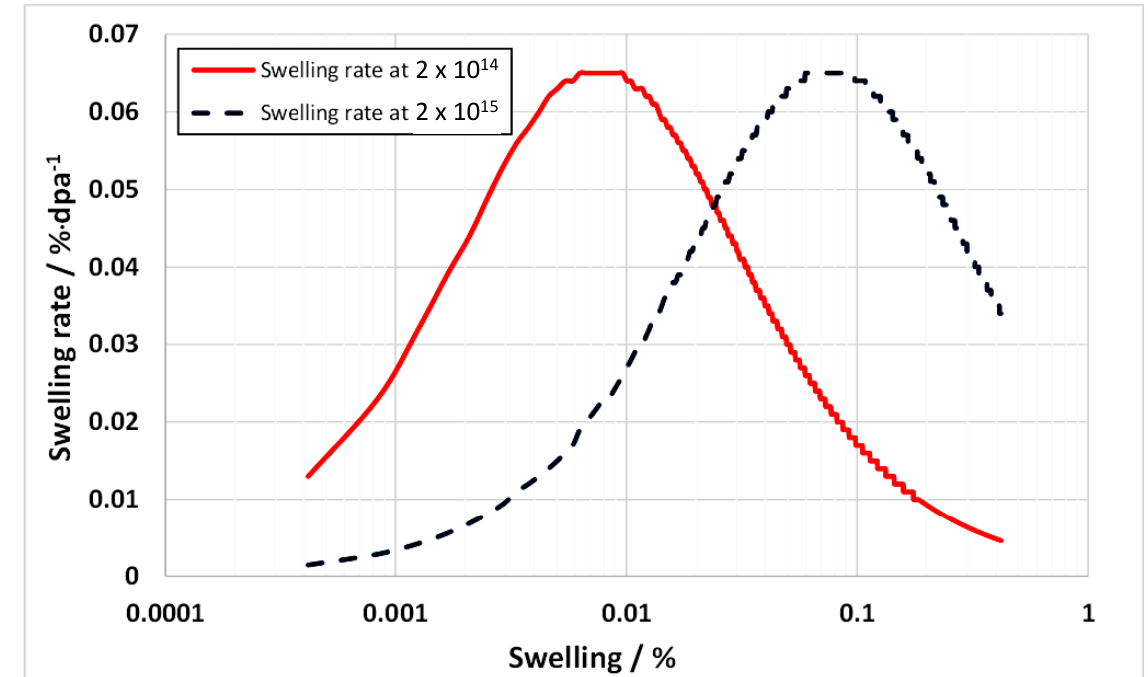
Figure 25. Calculated volume swelling rate (% per unit dpa) for nominal dislocation densities (ρ d ) of 2 × 10 14 m −2 (dotted curve) and 2 × 10 15 m −2 (dashed curve), spanning the likely range of dislocation densities for an unirradiated and irradiated alloy, as a function of void number density and a mean void radius of 1 nm. The output shown is for a nominal 1% cascade damage efficiency and b = 0.3. Modified from [38].